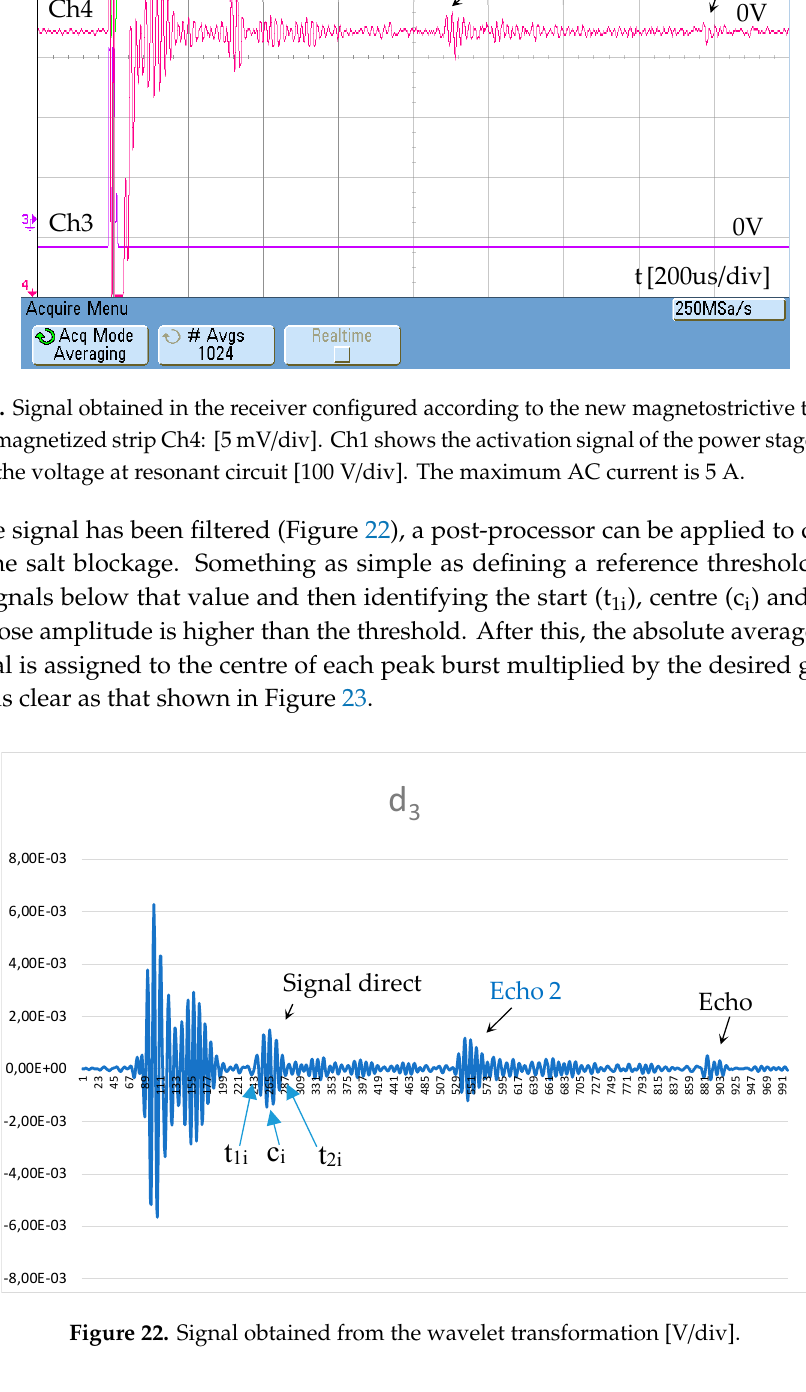
Figure 22. Signal obtained from the wavelet transformation [V/div].